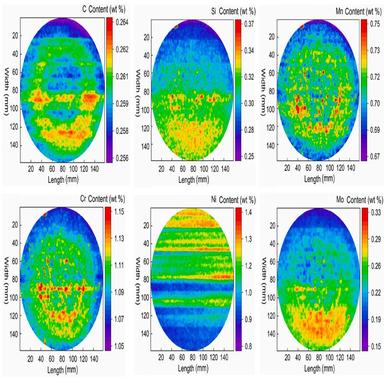
2-D raw content distribution of C, Si, Mn, Cr, Ni, Mo by row mapping.